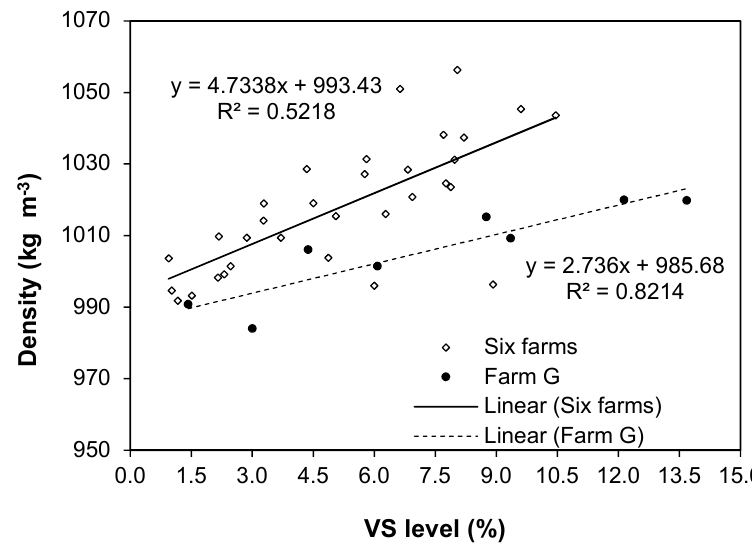
Figure 6. Density of post-digested manure as a function of volatile solids content.